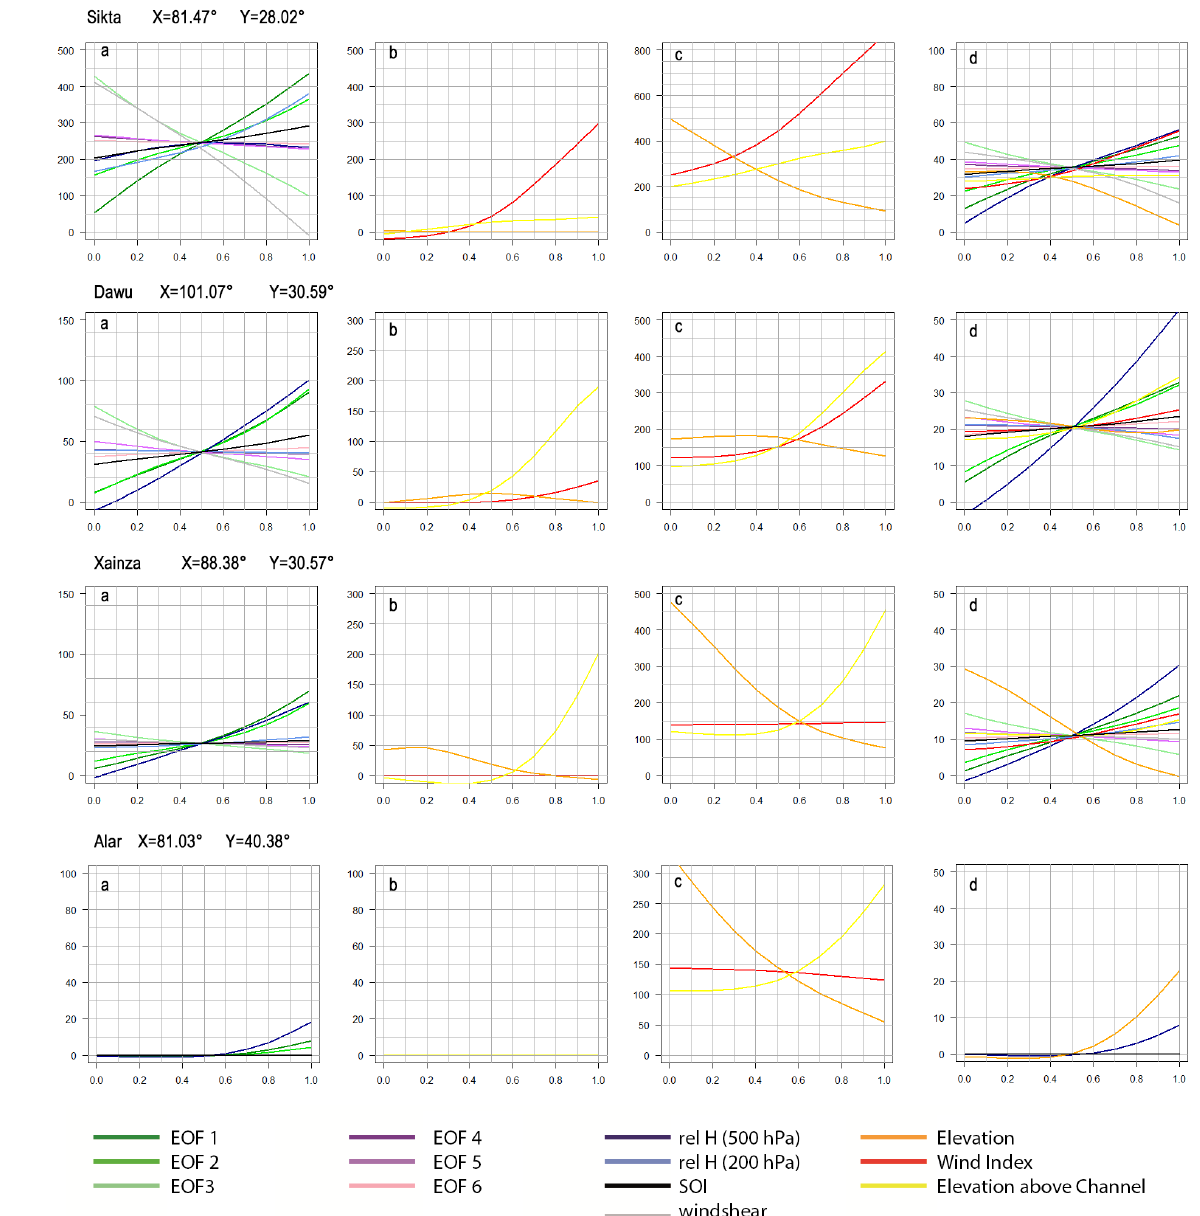
Figure 9. Sensitivity analysis of the ANN model for the atmospheric and topographic predictor variables at selected locations. Values are in millimeters. (a) Sensitivity of the modeled monthly precipitation sums to altering values of large-scale atmospheric predictor variables. (b) Sensitivity of monthly precipitation sums to topographic predictor variables under dry conditions. (c) Sensitivity of monthly precipitation sums to topographic predictor variables under moist conditions. (d) Generalized sensitivity analysis of maximum daily precipitation